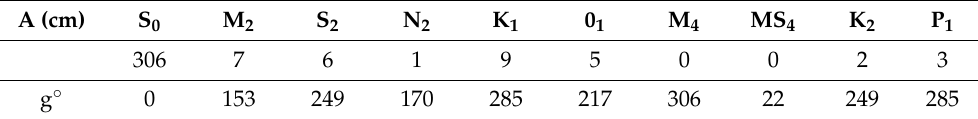
Table 1. Tidal harmonic constants.